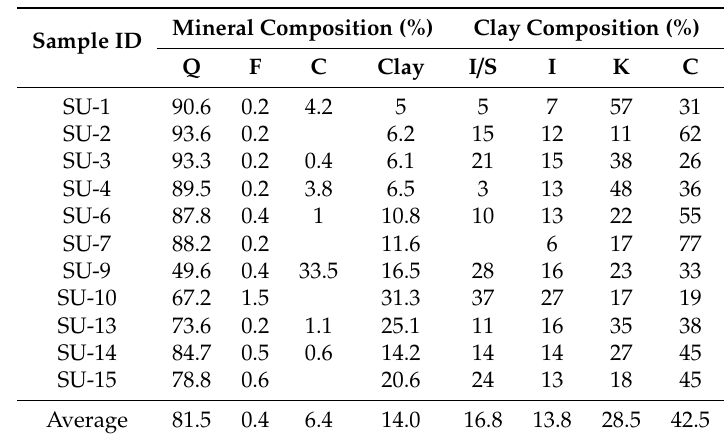
Table 1. Mineral composition based on X-ray di ff raction (X-RD) analysis of the eighth member of the Middle Permian Lower Shihezi Formation (He 8 Member) tight